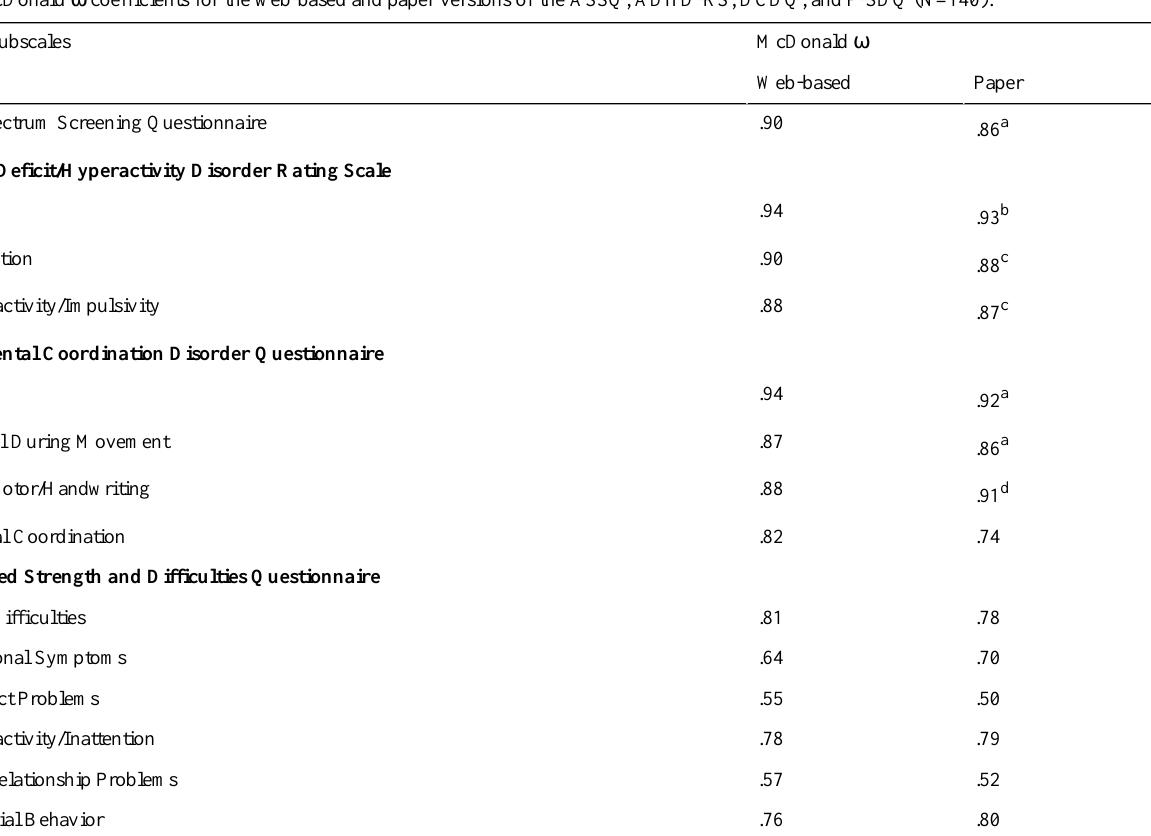
Table 2. McDonald ω coefficients for the web-based and paper versions of the ASSQ, ADHD-RS, DCDQ, and P-SDQ